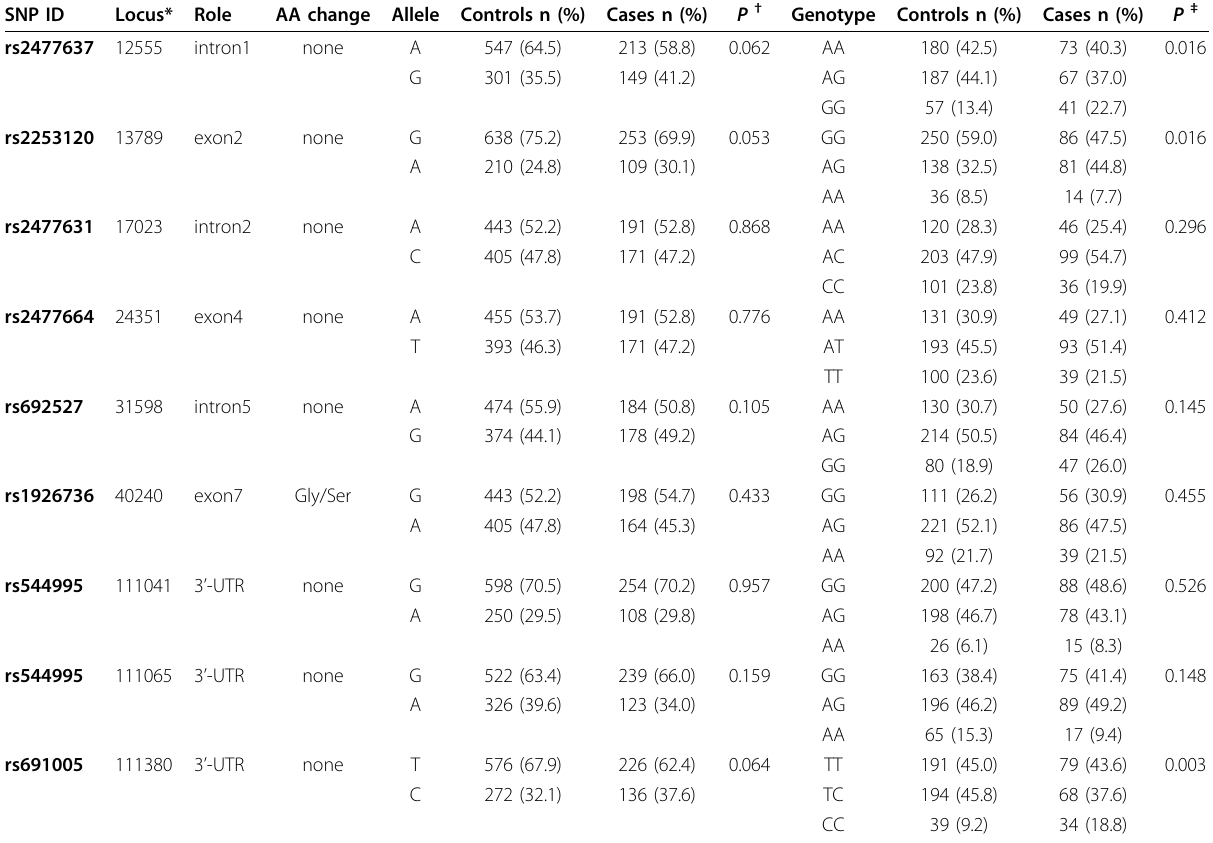
Table 3 Allele and genotype frequencies for 9 SNPs in MRC1 among subjects with sarcoidosis and control subjects SNP ID Locus* Role